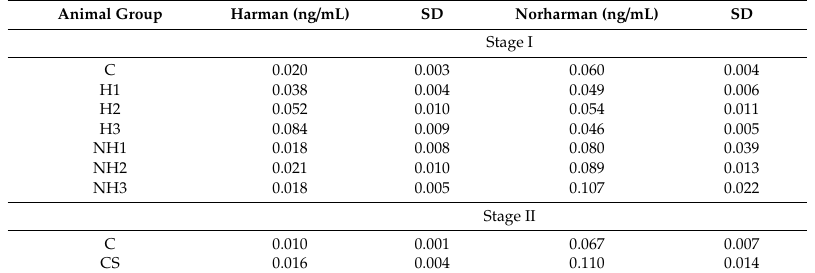
Stage I: LOD (limit of detection): H (0.013 ng / mL), NH (0.067 ng / mL); LOQ (limit of quantification): H (0.026 ng / mL), NH (0.137 ng / mL); C = control; H1 = 10 µ g H / kg of exp. diet, H2 = 15 µ g H / kg of exp. diet; H3 = 20 µ g H / kg of